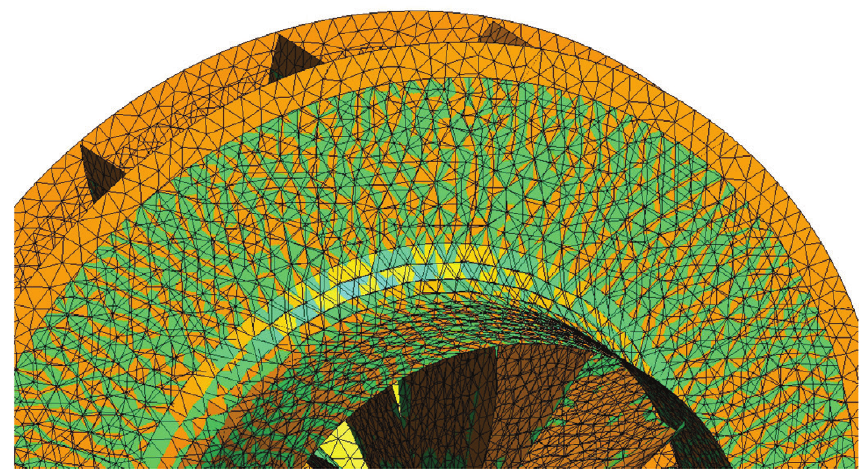
Figure 23 - Original (yellow) and modified (green) rotor